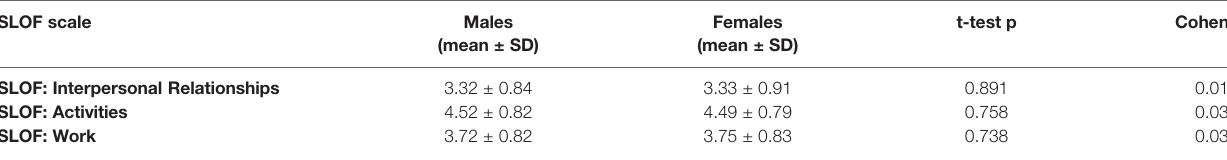
TABLE 3 | Functional outcome differences between male and female patients (t-test). SLOF